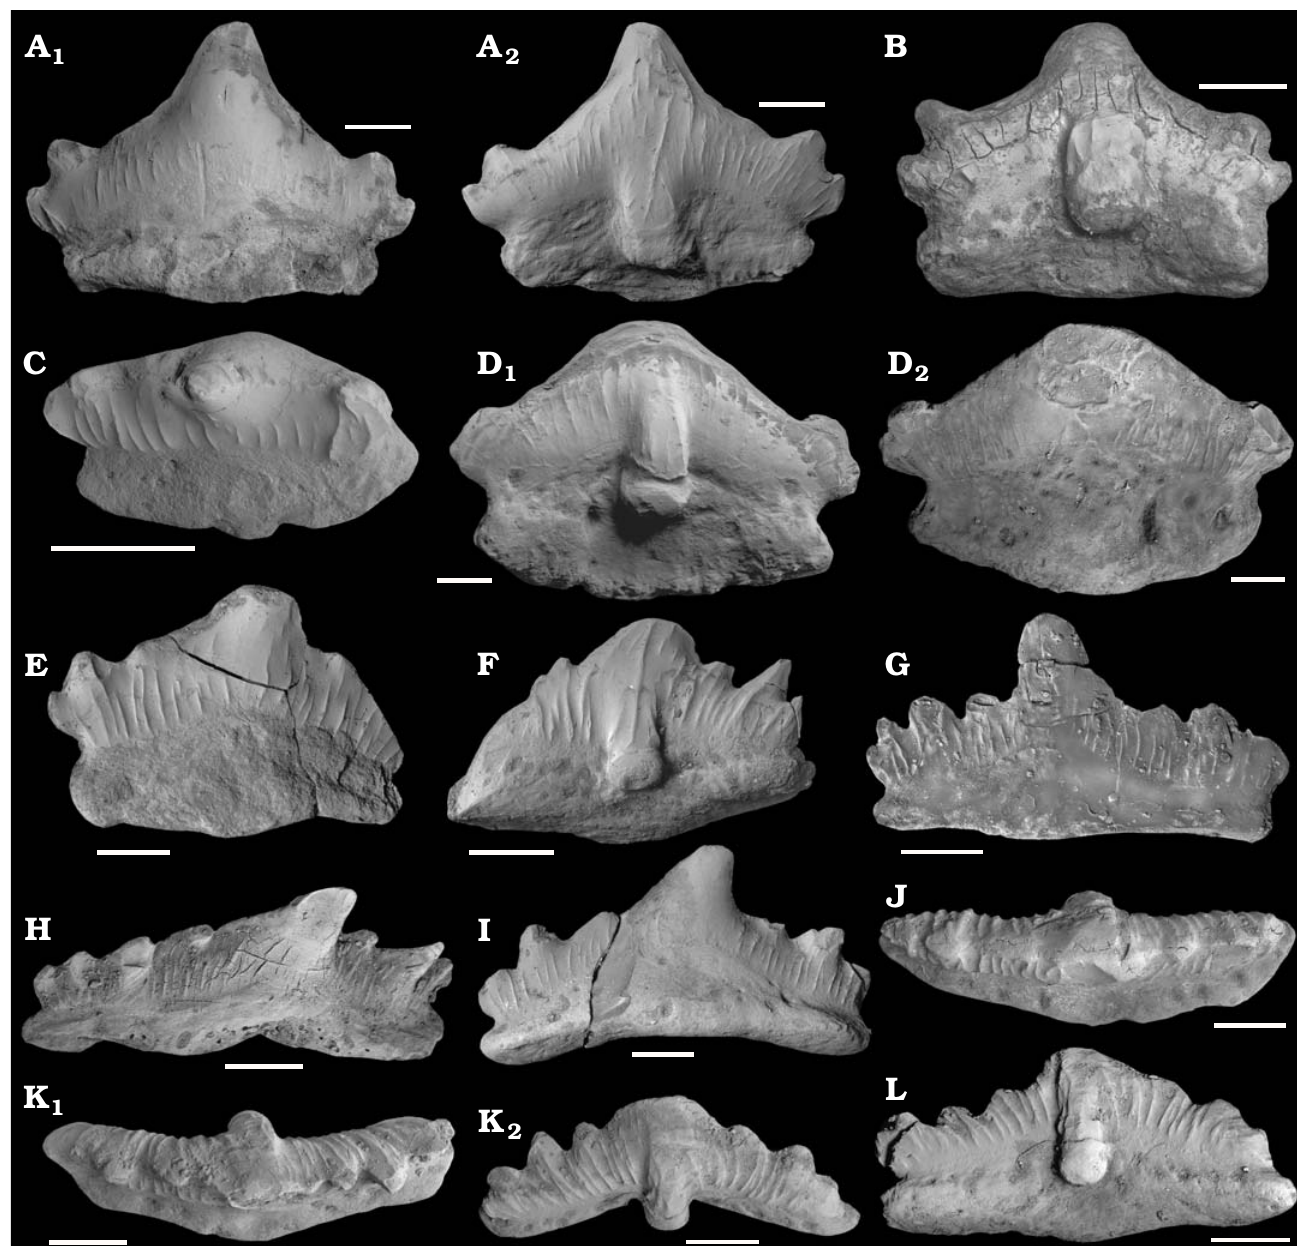
Fig. 2. Teeth of the euselachian shark Artiodus prominens Ivanov and Duffin gen. et sp. nov. from the Artinskian (Early Permian) of Krasnoufimskie Klyuchiki quarry (Middle Urals, Russia). A . PM SPU 81-1, holotype, lingual (A 1 ) and labial (A 2 ) views. B . PM SPU 81-2, labio-basal view. C . PM SPU 81-3, occlusal view. D . PM SPU 81-4, labio-basal (D 1 ) and lingual (D 2 ) views. E . PM SPU 81-5, lingual view. F . PM SPU 81-6, labio-basal view. G . PM SPU 81-7, lingual view. H . PM SPU 81-8, lingual view. I . PM SPU 81-9, lingual view. J . PM SPU 81-10, occlusal view. K . PM SPU 81-11, occlusal (K 1 ) and labial (K 2 ) views. L . PM SPU 81-12, labio-basal view. Scale bars 1 mm. All SEM